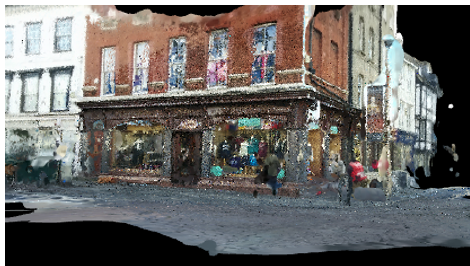
Figure 4. Example of a rendered image from the 3D model. The 3D model is generated from the captured training images.